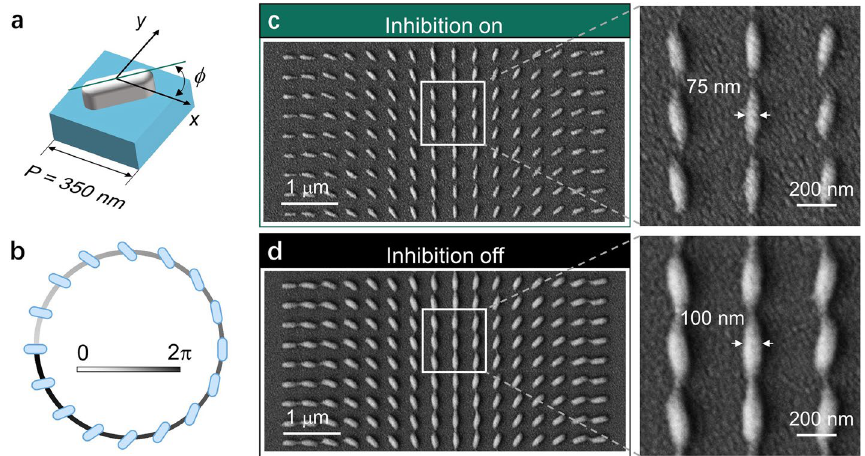
Fig. 4 Super-resolution DLW of geometric metasurfaces with 16 phase levels. a A cell unit of the nanorod-based metasurface fabricated by SC-PPI. The cell structures are arranged at periods of P and with the orientation angles φ . b The nanorods with 16 orientation angles offer transmitted light phase responses from 0 to 2π. c‑d Comparison between the metasurfaces with the inhibition beam on ( c ) and off ( d ) illustrates that the inhibition beam not only decreases the width of nanorods from 100 nm to 75 nm, but also mitigates